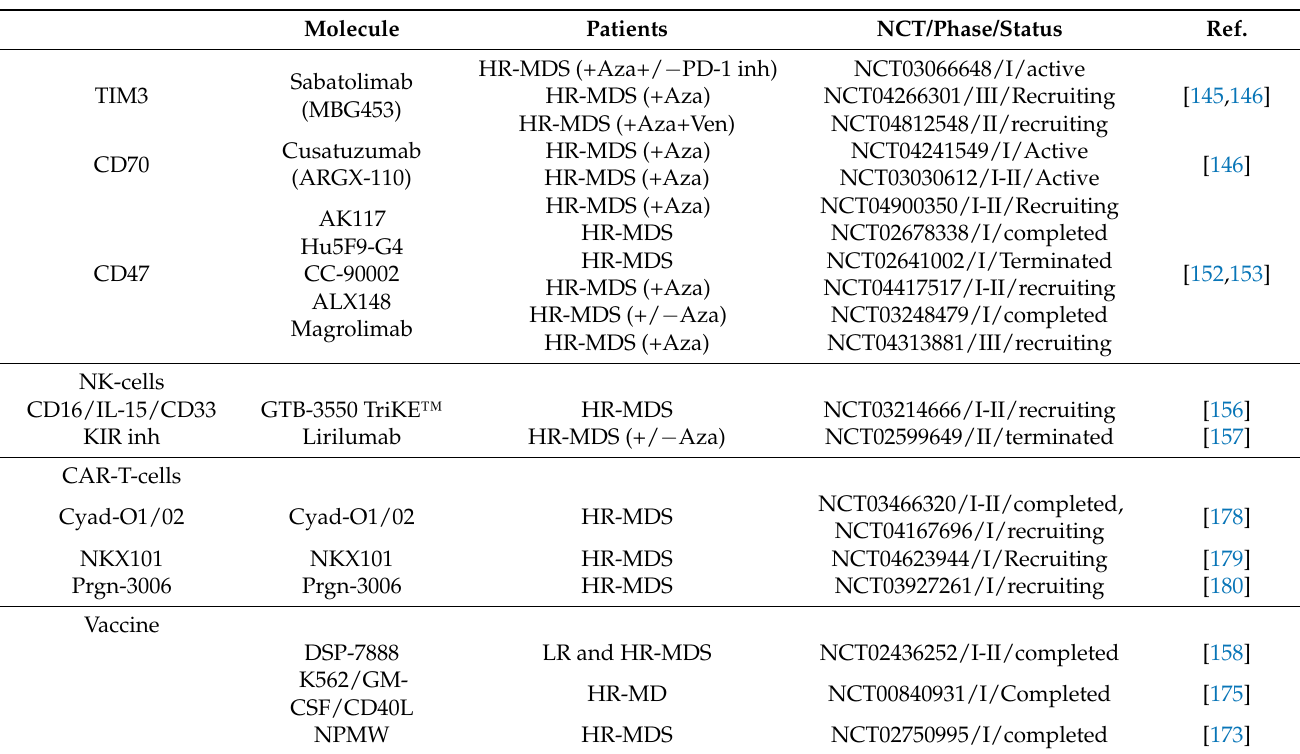
Table 1. Cont. Molecule Patients NCT/Phase/Status